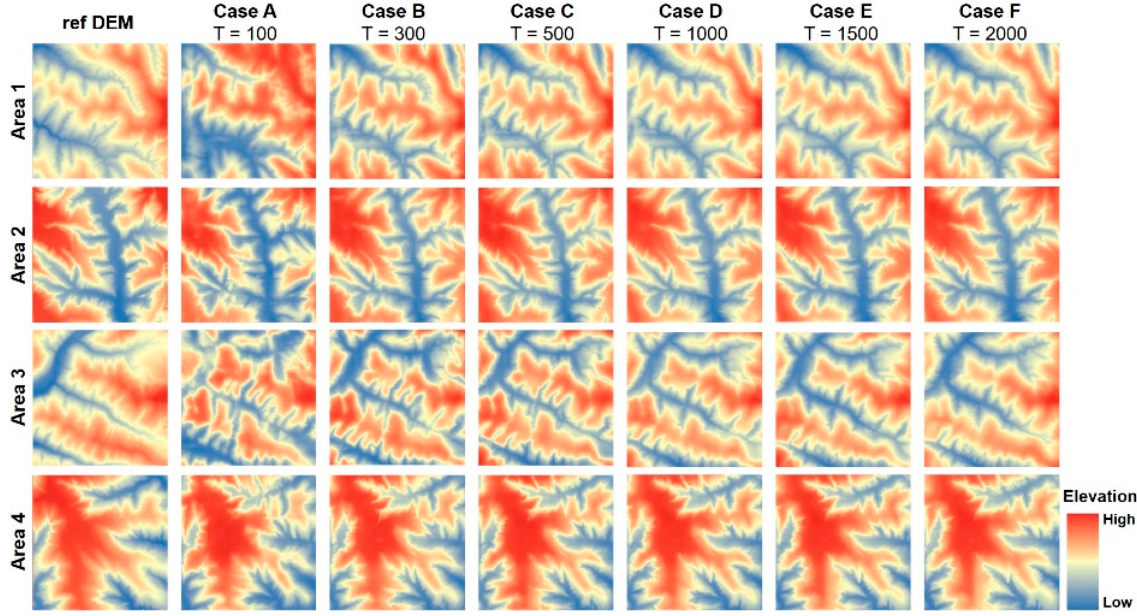
Figure 5. Results based on the combinations generated by different thresholds. Ref DEM represents the reference data, and T represents the threshold for extracting stream network.